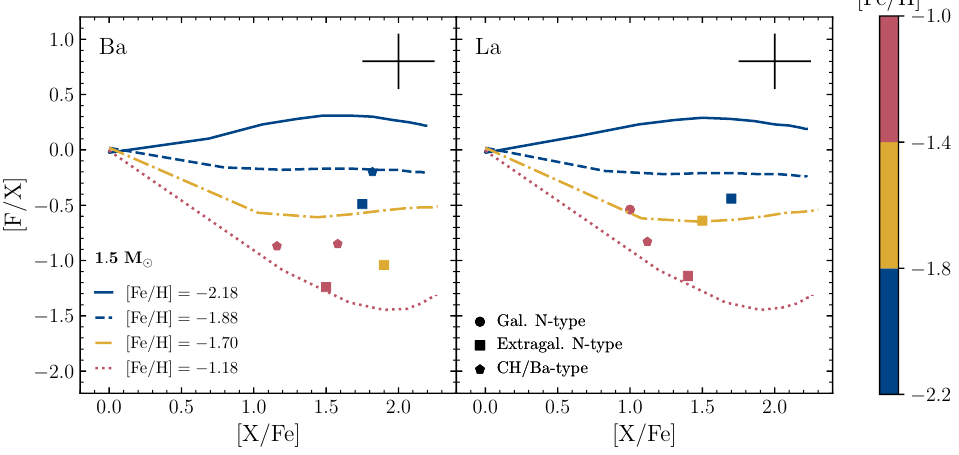
Figure 3. [F/X] against [X/Fe] for the sample stars with [Fe/H] groups: circles, galactic (N-type) carbon stars; squares, extragalactic carbon stars; pentagons, extrinsic CH/Ba stars. Data from Abia et al. [171], Lucatello et al. [172]. The lines are theoretical predictions for 1.5 M AGB stars with low metallicity. Note that at these low metallicities, theoretical AGB models (cid:12) predict that the star becomes C-rich from the first TDU episodes. Data points and theoretical lines are color-coded by [Fe/H]. Typical error bars are